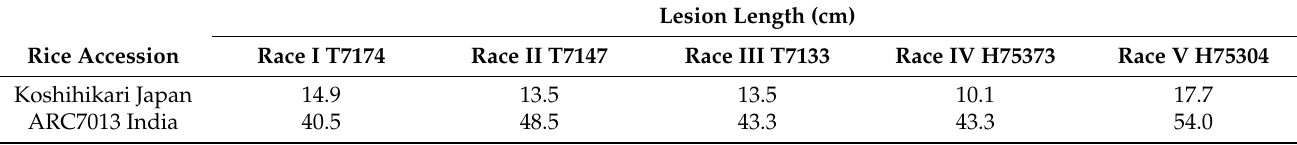
Table 1. Average of lesion length (cm) reactions of rice accessions: Koshihikari and ARC7013 after inoculation with five Japanese races of Xanthomonas oryzae pv. oryzae. Lesion Length (cm) Rice Accession